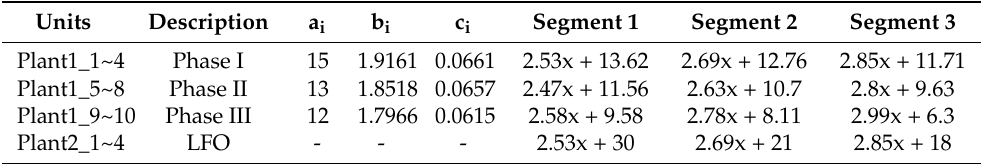
Table 2. The parameters for piecewise linear for the diesel